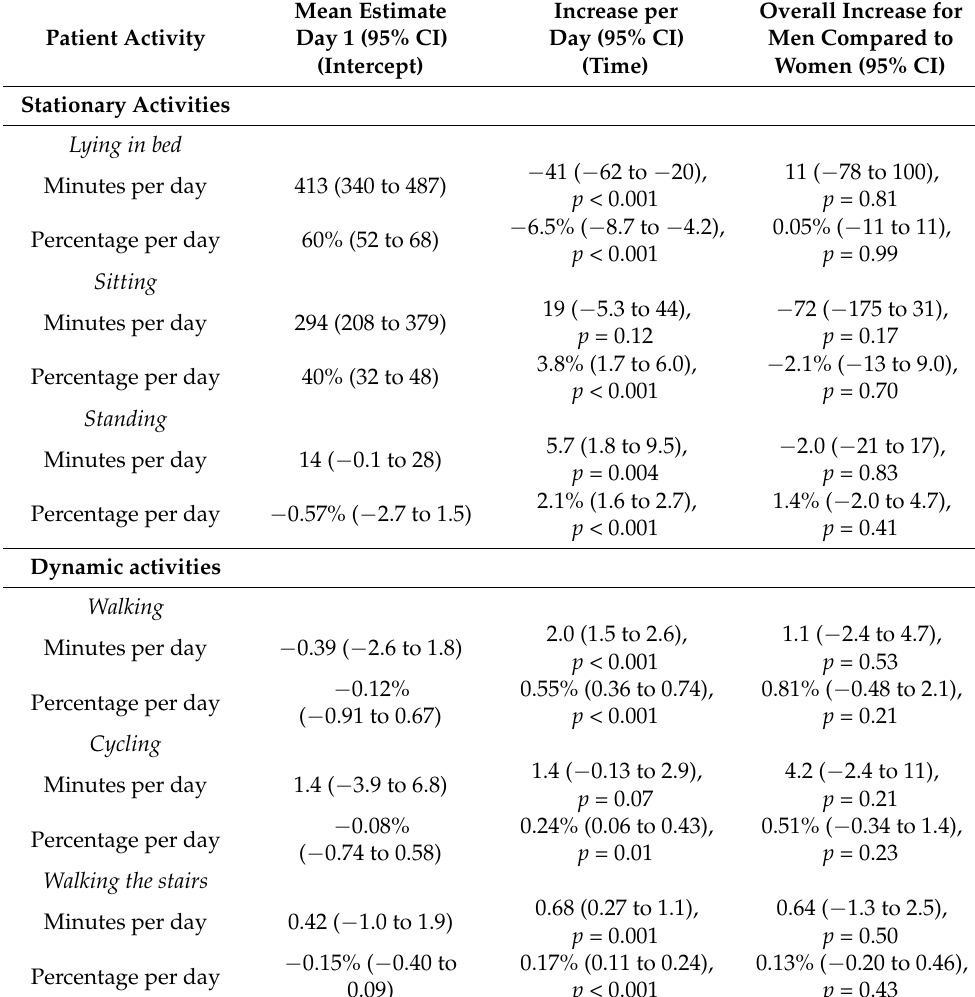
Table 5. Patient activities during their hospital stay between 7 a.m. and 11 p.m., as measured with the accelerometer, and the fixed effects analysis ( n =